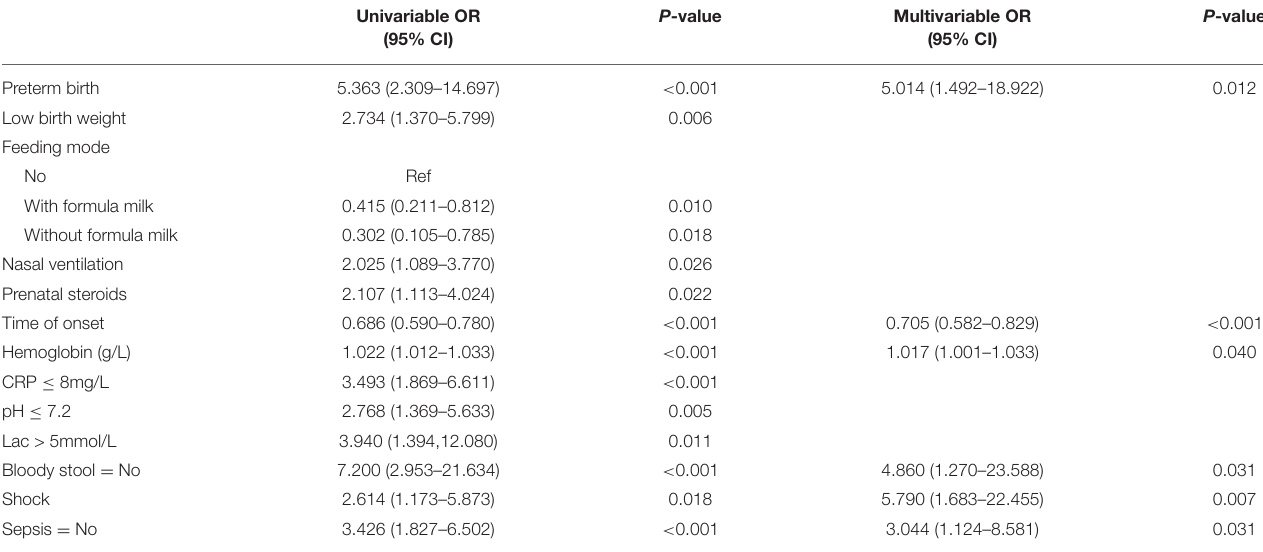
TABLE 4 | Univariable and multivariate logistics regression analysis.